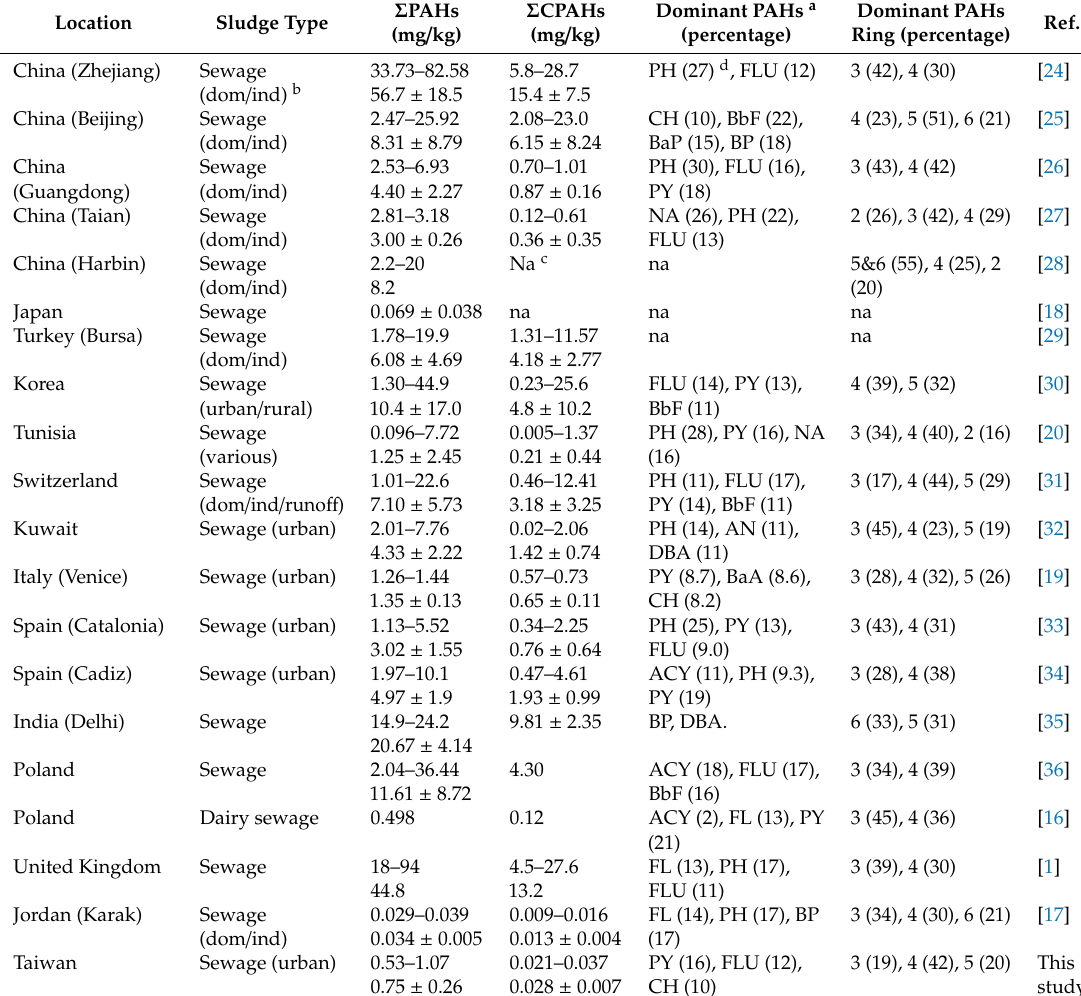
Table 5. Compare the concentrations and composition of PAHs in sludge from other studies around the